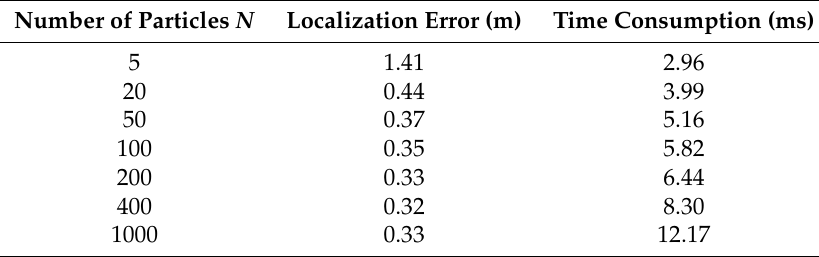
Table 5. The influence of the number of particles N on the experimental